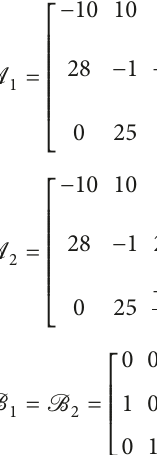
Figure 5: State response of the fuzzy semi-Markov chaotic system (11) with control